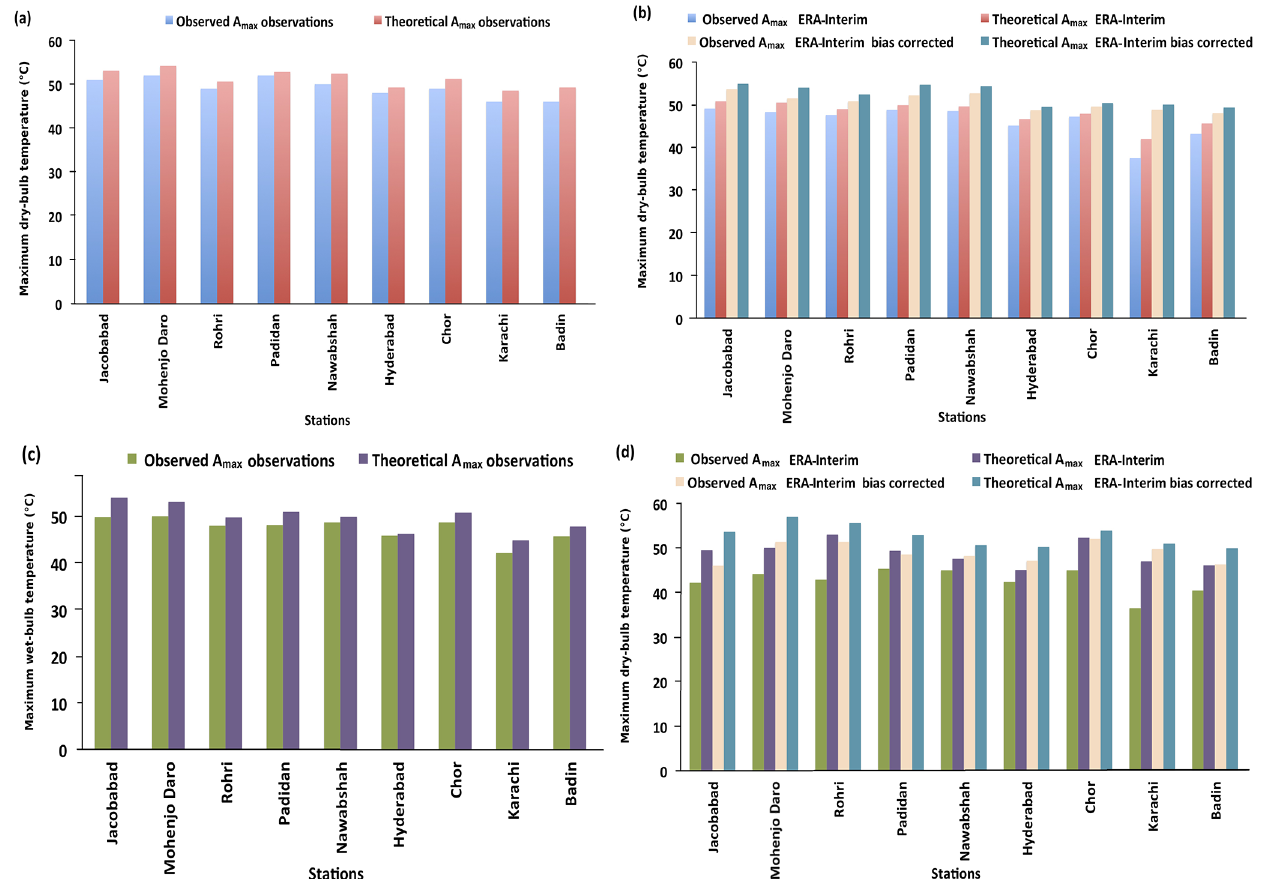
Figure 5. Absolute maxima A max in degrees Celsius. (a) Station-observed T max . (b) ERA-Interim and bias-corrected ERA-Interim T max . (c) Station-observed TW max . (d) ERA-Interim and bias-corrected ERA-Interim TW max